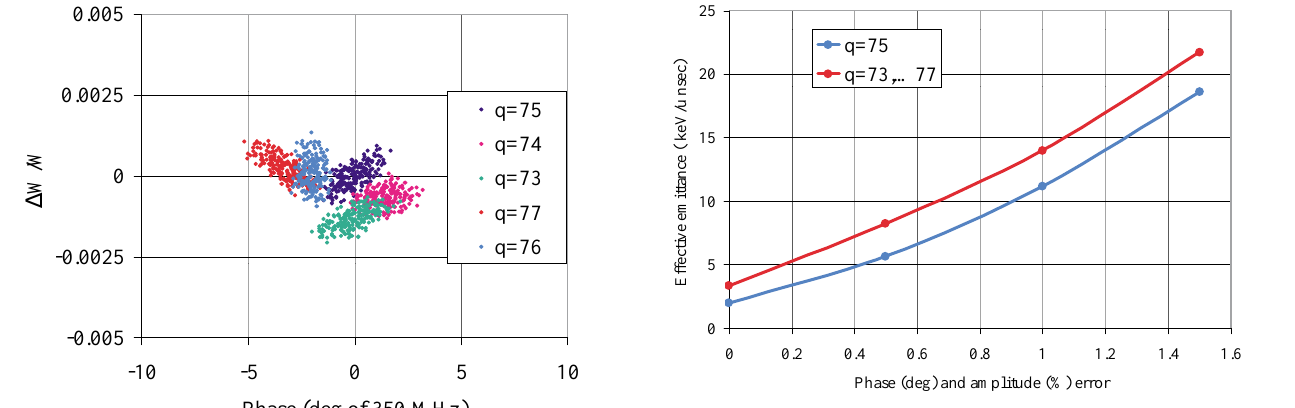
FIG. 8. (Color) Longitudinal emittance as a function of rf phase error for one charge state (blue curve) and five charge state (red curve)